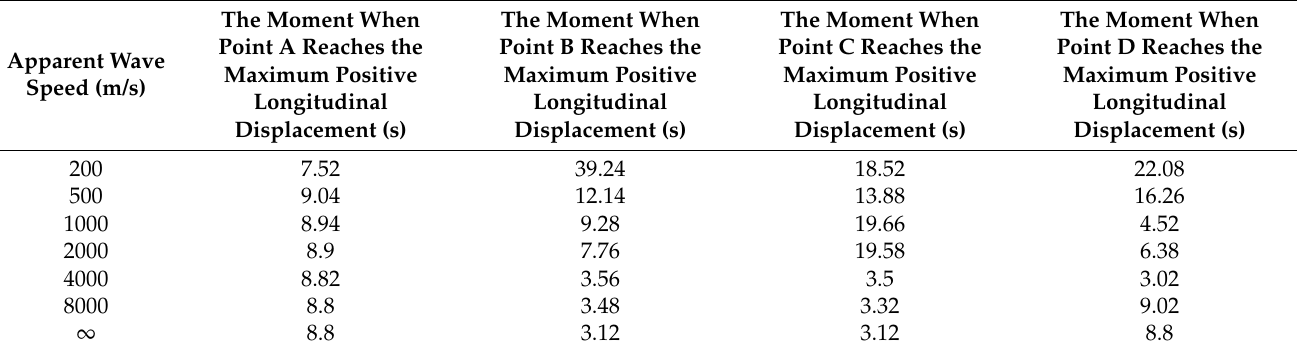
Table 8. Time for each position to reach the maximum positive longitudinal displacement at different apparent wave